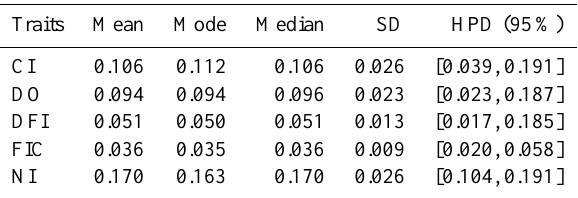
Table 3. Summary of marginal distributions of the repeatability of CI, DO, DFI, FIC, and